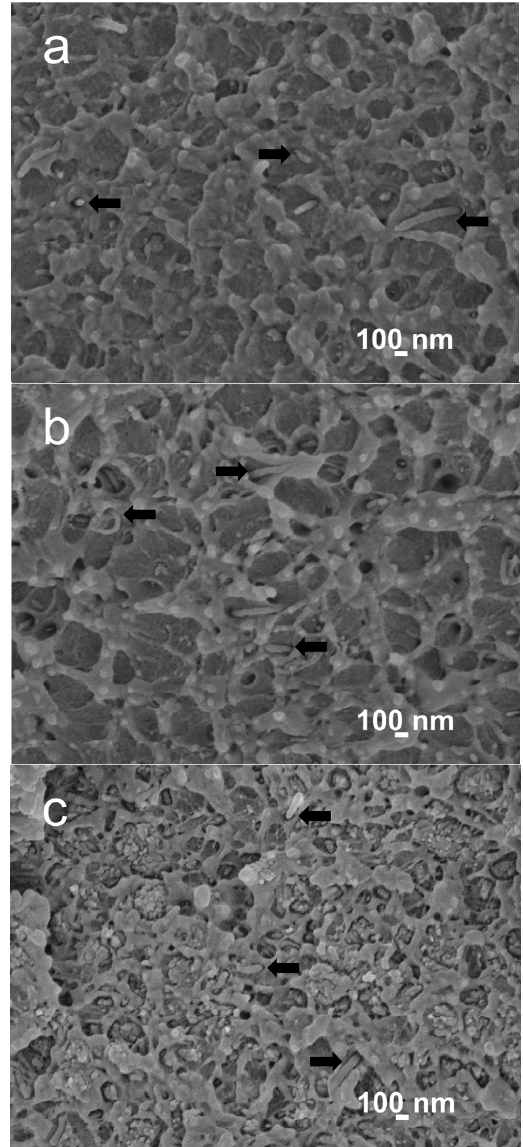
Figure 3. Scanning electron microscopy (SEM) images of ( a ) PEEK/(0.93 vol % MWNT); ( b ) PEEK/(1.88 vol % MWNT) and ( c ) PEEK/(15% nHA)-(1.88% MWNT) nanocomposites. Black arrows indicate MWNT fillers.